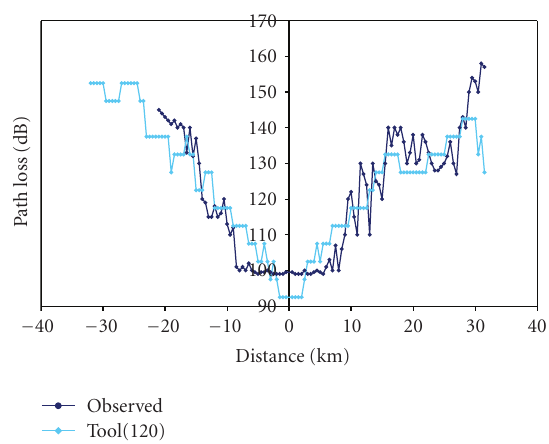
Figure 9: Comparison of tool predicted losses with observed losses versus track distance for Neral base station.